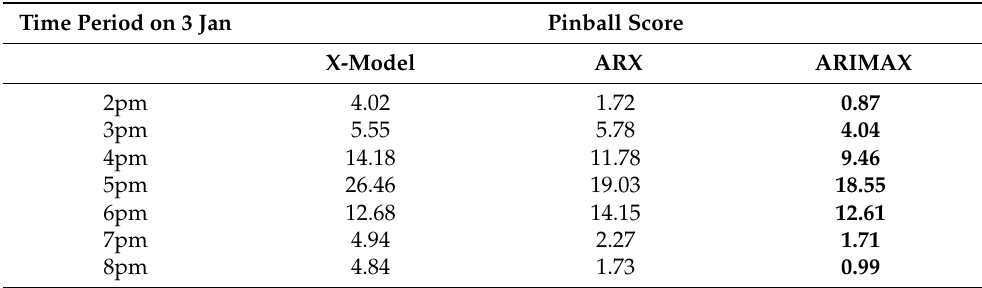
Figure 24. Quantile estimates (red) for 3 January 2019 for each of the forecast models. The actual is shown in black. Table 5. Pinball scores for the peak hours on 3 January 2019 for the three forecast models. In bold are the best scores for that time